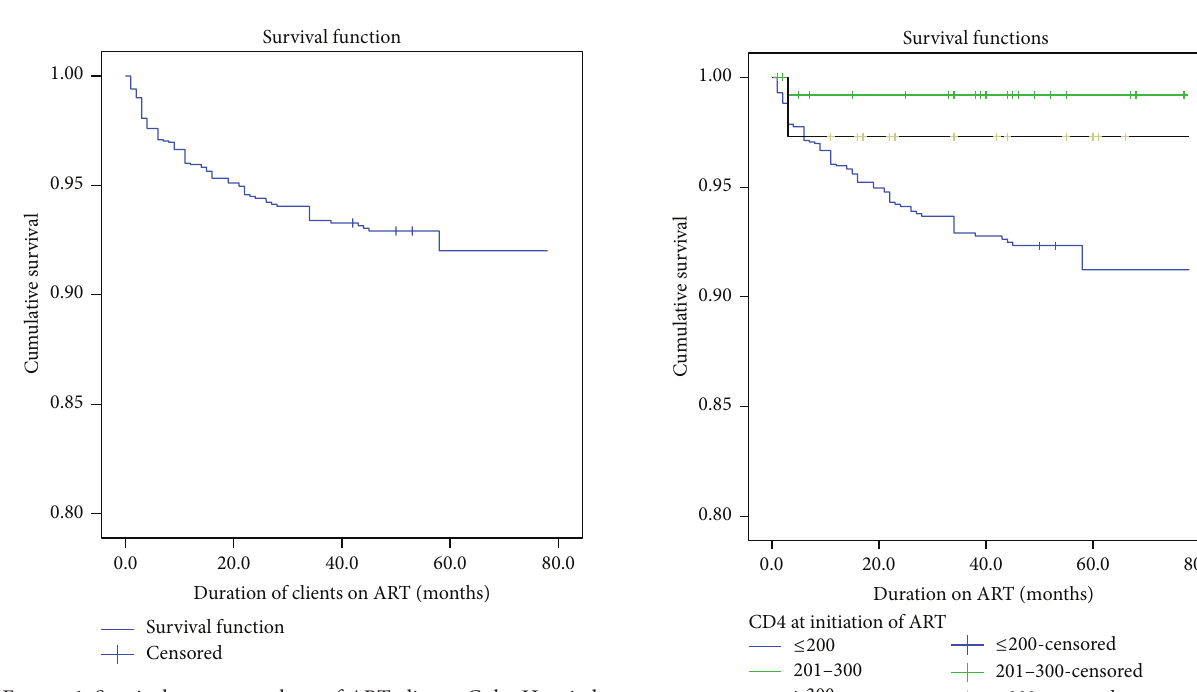
Figure 1: Survival among a cohort of ART clients, Goba Hospital, Southeast Ethiopia, 2013.